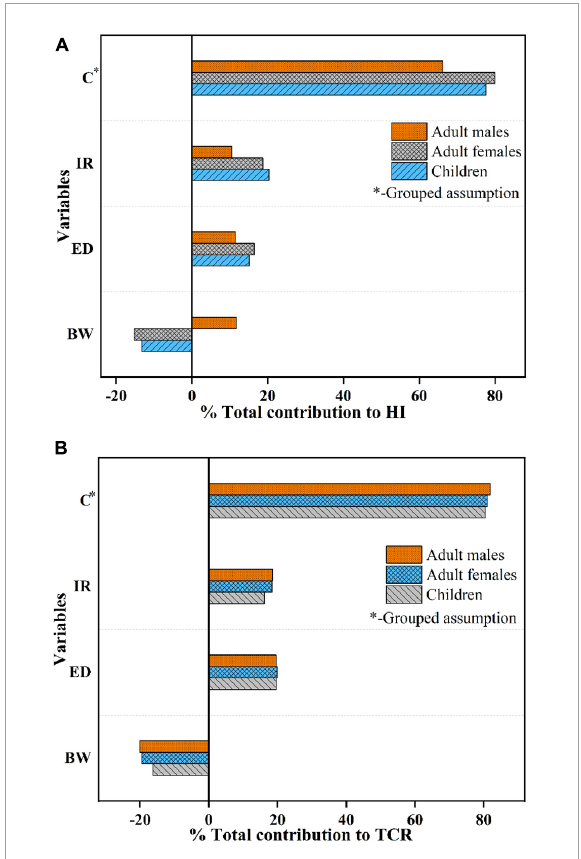
FIGURE7 Sensitivity analysis of the input parameters for (A) hazard index (HI) and (B) threshold carcinogenic risk (TCR) for three populations (children, adult females, and adult